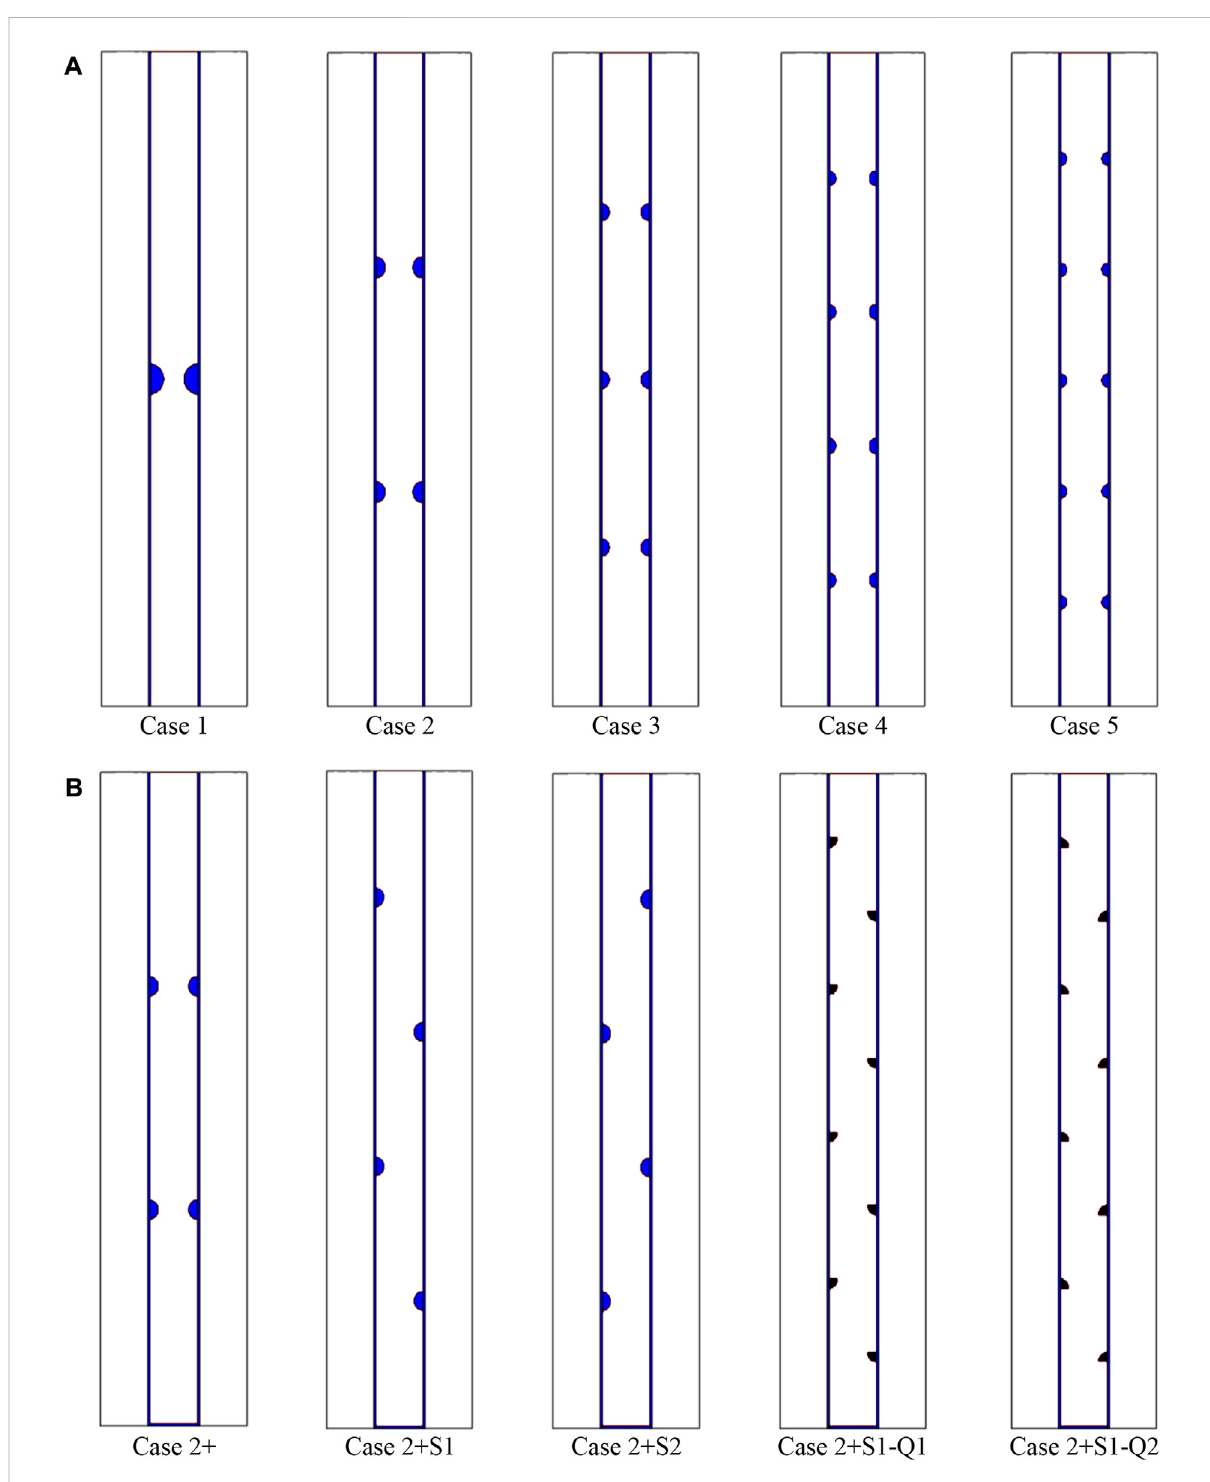
FIGURE 2 Schematic of the proposed system on the effect of (A) the number of hemispherical fi ns without an added fi n to the bottom and (B) case 2 modi fi ed to several con fi gurations to reach a better thermal performance of the system.